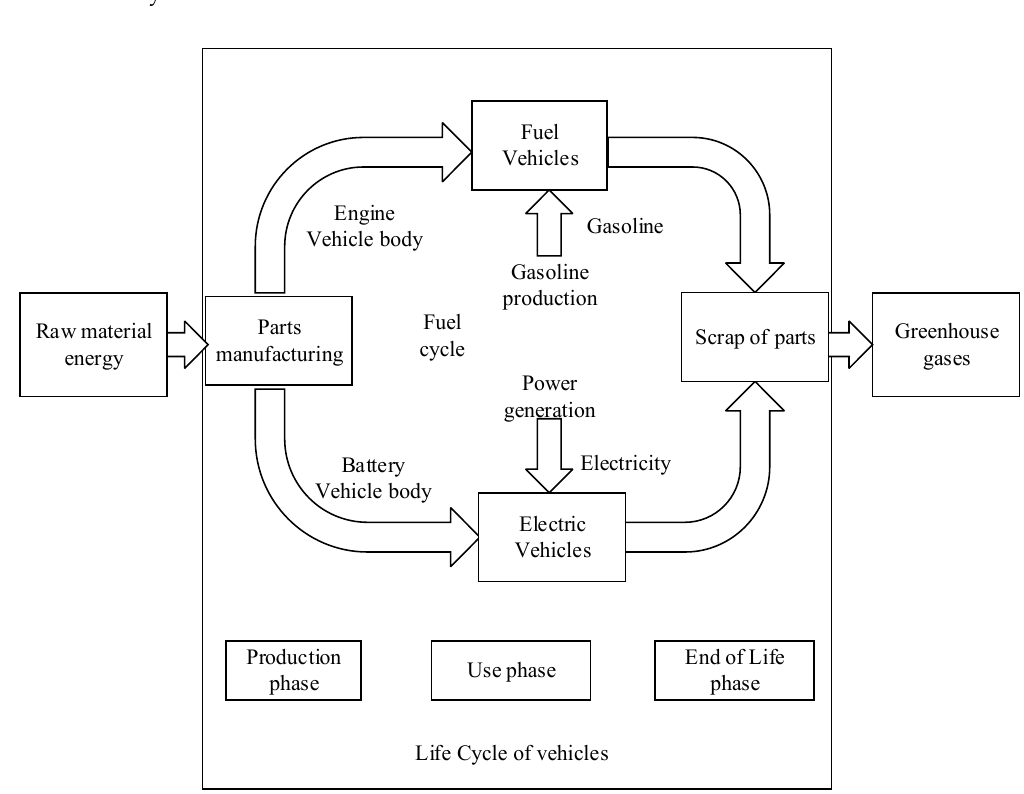
Figure 2. System boundary of Life Cycle Assessment for electric vehicles and fuel vehicles.